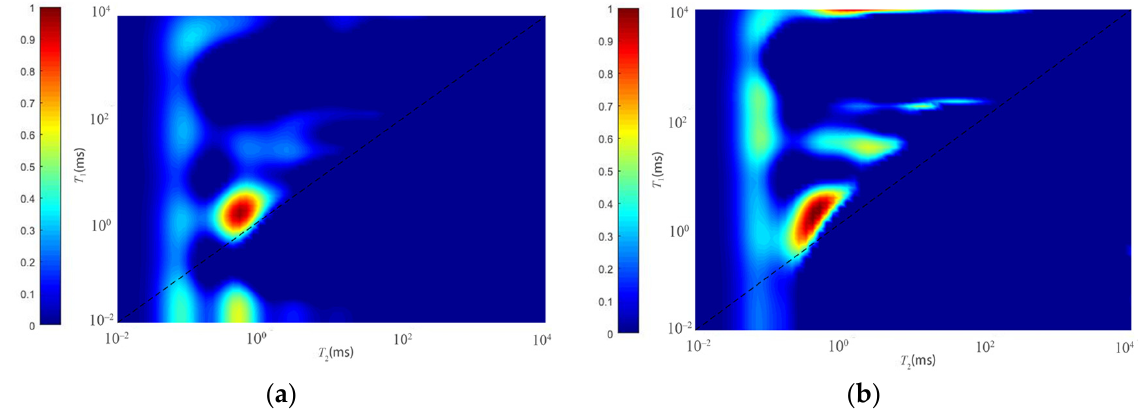
Figure 7. T 1 - T 2 maps of shale at different states. ( a ) Saturated with water, ( b ) saturated with D4.